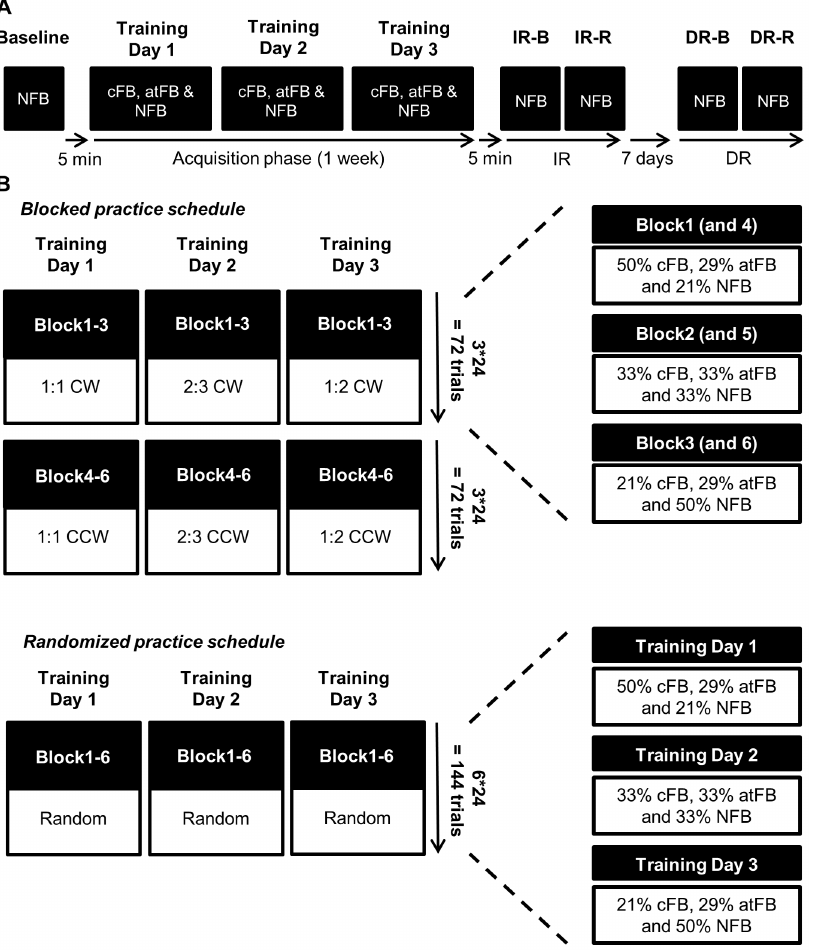
Figure 3. Training schedule. (A)Trainingprotocol . Baseline performance was assessed without concurrent FB (NFB) on day 1 prior to training. The acquisition phase consisted of 3 training days within one week. Because of the fading feedback schedule, all 3 feedback conditions were present during each day of training. Immediate retention (IR) was conducted 5 min after the end of training day 3 and delayed retention (DR) was conducted 7 days later. Both IR and DR consisted of 2 types of retention schedule, i.e. a blocked (IR-B and DR-B) and a random (IR-R and DR-R) schedule. (B) Blockedandrandomizedpracticeschedule . Subjects in the blocked practice group were exposed to one frequency ratio in both clockwise (CW) (blocks 1–3) and counterclockwise (CCW) (blocks 4–6) directions per day. In contrast, subjects in the randomized practice group were exposed to all 6 trial types (which were randomly presented) during each block, i.e. 4 trials per trial type in each block during training. The number of different feedback (cFB, atFB and NFB) trials and the degree of fading feedback within each trial type was identical in both groups. Therefore, concurrent feedback (cFB) in the blocked practice group faded over blocks 1 to 3 after which the fading feedback schedule repeated itself during the next 3 blocks. In contrast, in the randomized practice group, fading feedback was distributed over days within each trial